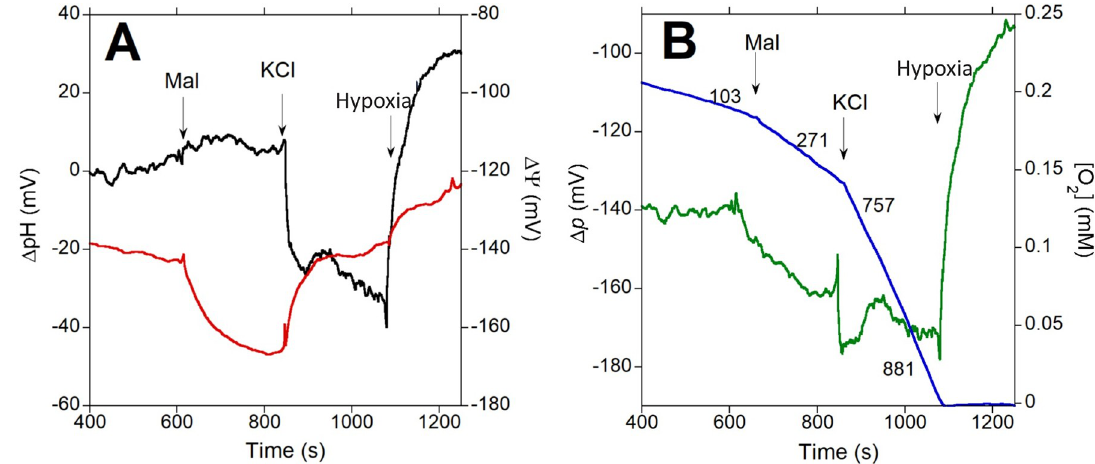
Fig 5. Simultaneous determination of Δ pH and Δ C to calculate Δ p as a function of respiration rate. 2.5 x 10 9 K + -depleted cells/ml expressing 3 copies of pH-sensitive GFP were incubated in depletion buffer to which 16.5 mM sodium malate (Mal) was added at the indicated time point followed by 10 mM KCl. In panel A, Δ pH (black) and Δ C (red) were determined as described in Methods to calculate Δ p (green), shown in panel B overlayed with the O 2 concentration trace (blue) showing respiration rates recorded after the indicated